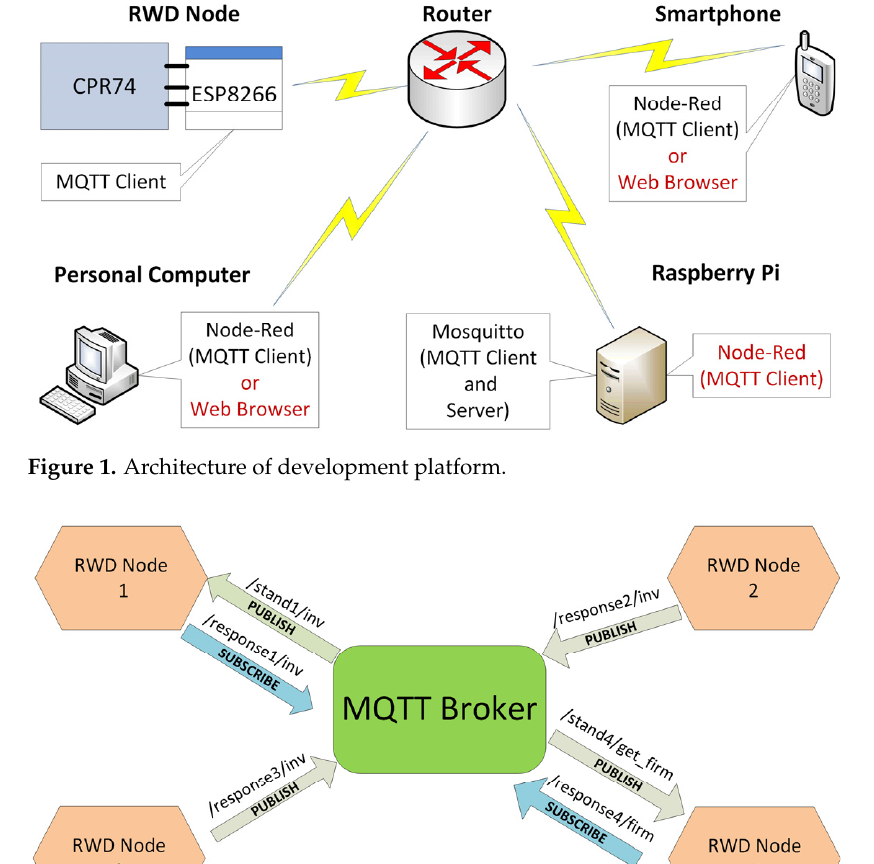
Figure 1. Architecture of development platform.